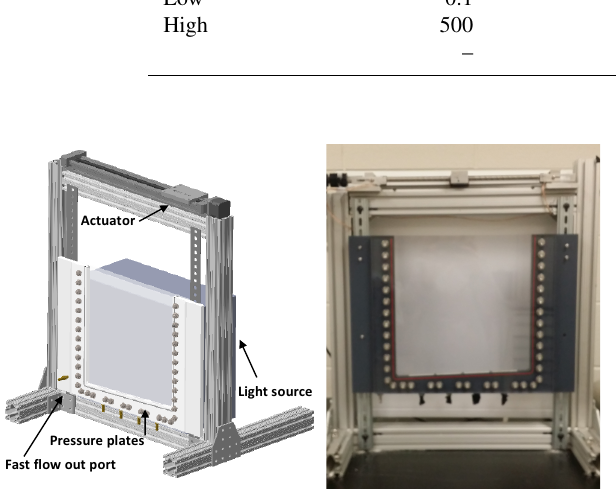
Figure 2. Experimental set up of the 2-D tank system.